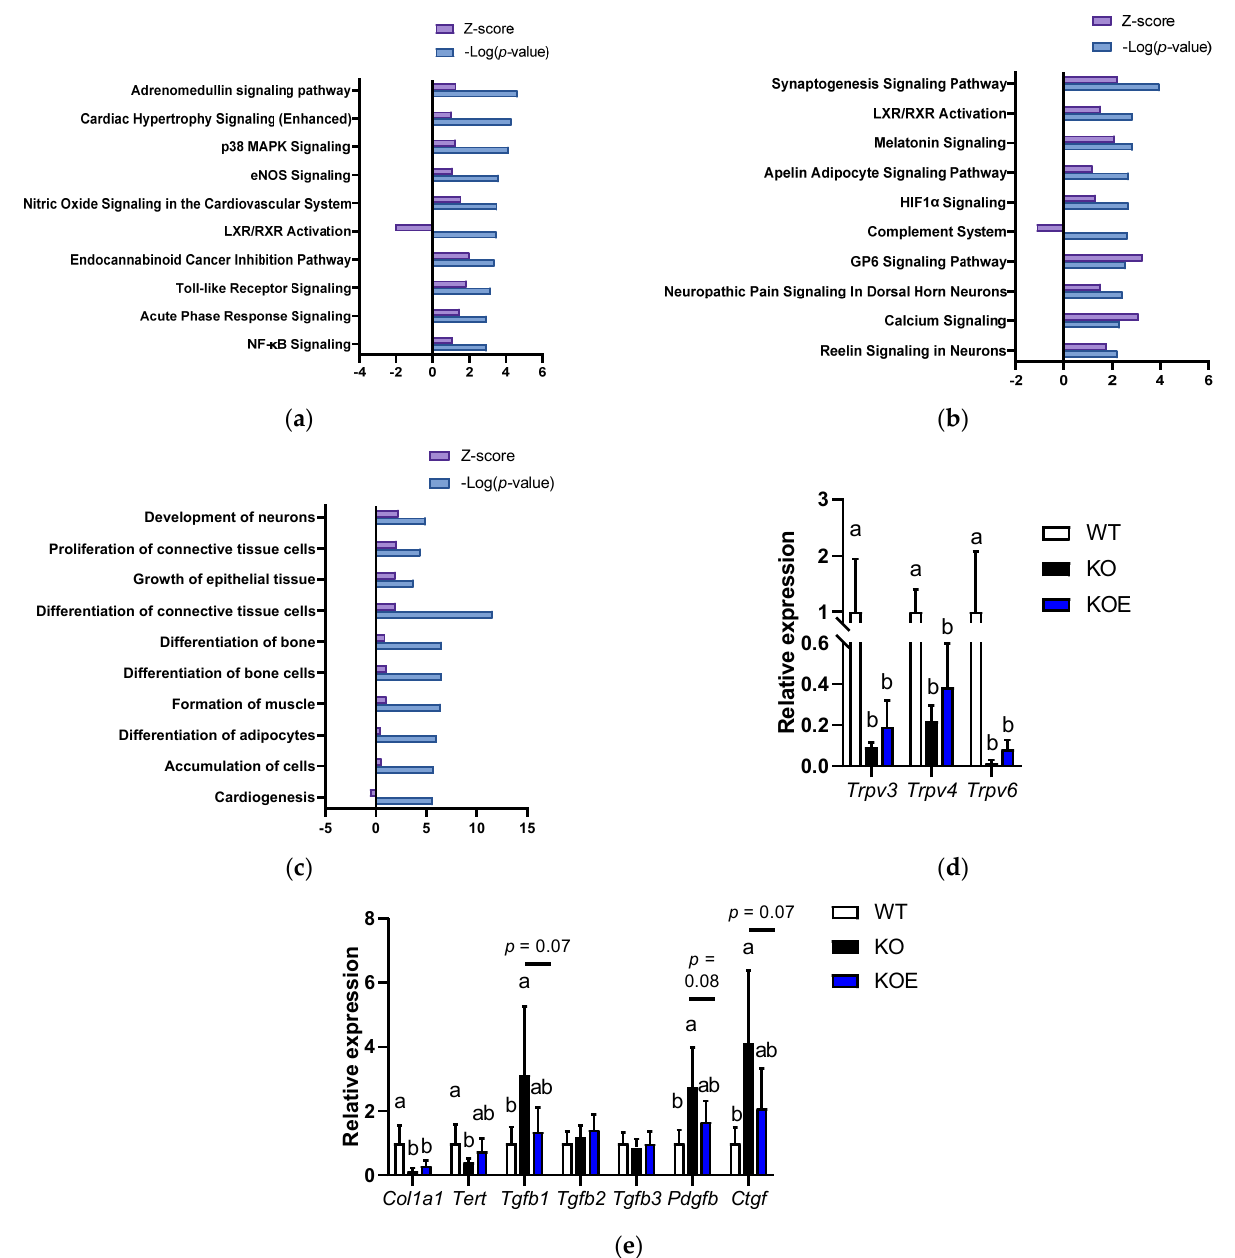
Figure 4. DNA microarray analysis on pESM supplemented IL10 KO mice. ( a , b ) Canonical analysis comparison between the KO and WT groups ( a ) and between the KOE and KO groups ( b ) using IPA software. In both analyses, the cut-off condition was |Activation Zscore| > 1, and data was sorted by − Log ( p -value); ( c ) Disease and function analysis comparison between the KOE and KO groups using IPA software. The cut-off condition was |Activation Zscore| > 1, and data was sorted by − Log ( p -value); ( d , e ) Results of real-time RT-PCR on calcium channel ( d ) and skin aging-related genes ( e ). Data are means ± SD, n = 5, 7 and 6 for WT, KO and KOE groups, respectively, and expressed as fold change values compared with the WT group. WT: Wild type, KO: IL10 knockout mice, KOE: KO mice supplemented with pESM. The different lowercase alphabets indicate significant differences between the tested-group ( p <